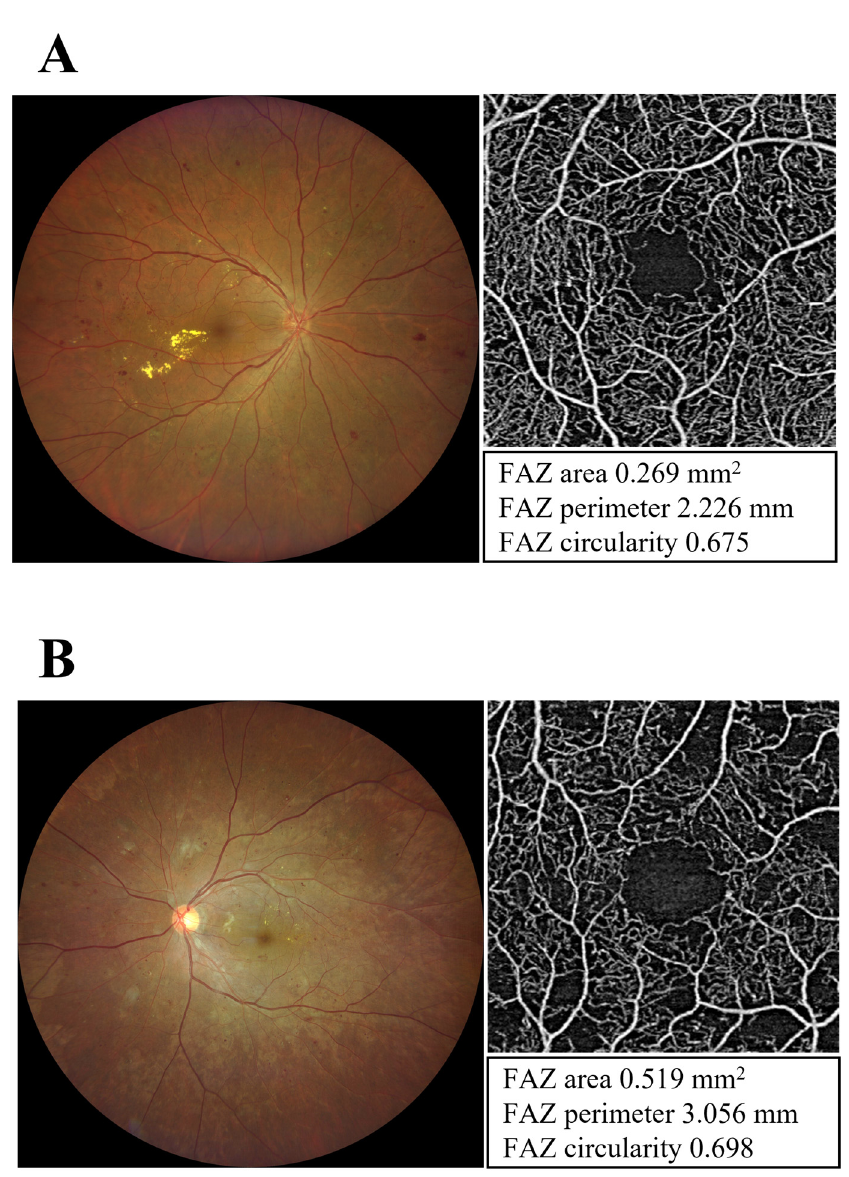
Figure 1. Fundus photograph of diabetic retinopathy and foveal avascular zone (FAZ) on optical coherence tomography angiography (OCTA). FAZ area, perimeter, and circularity were quantitatively evaluated from 3 × 3-mm en-face OCTA images using Macular Density version 0.7.2 on the ARI Network (Zeiss Portal version 5.4-1206) from 3 × 3-mm en-face OCTA images. The eyes were divided into two groups according to the presence or absence of diabetic macular ischemia (DMI) at the baseline: ( A ) no DMI group, eyes without DMI; and ( B ) DMI group, eyes with DMI. DMI was defined as a FAZ area on OCTA of ≥ 0.5 mm 2 or a FAZ area < 0.5 mm 2 with parafoveal capillary dropout in at least one quadrant.